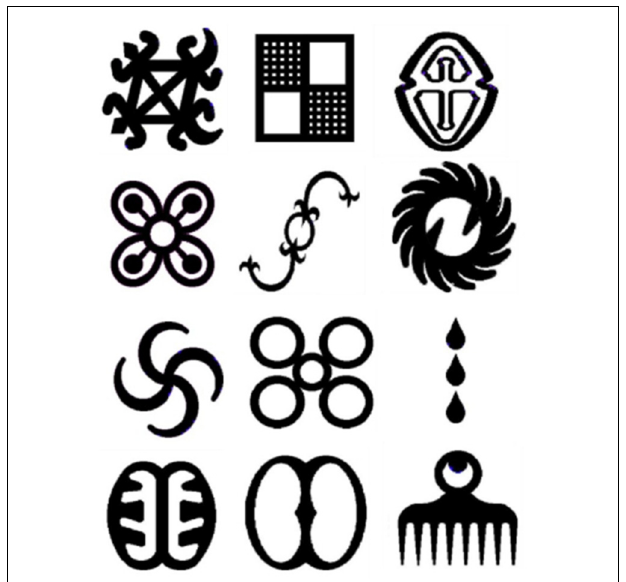
FIGURE 1 | Stimuli of the visual non-verbal segmentation task ordered into triplets.